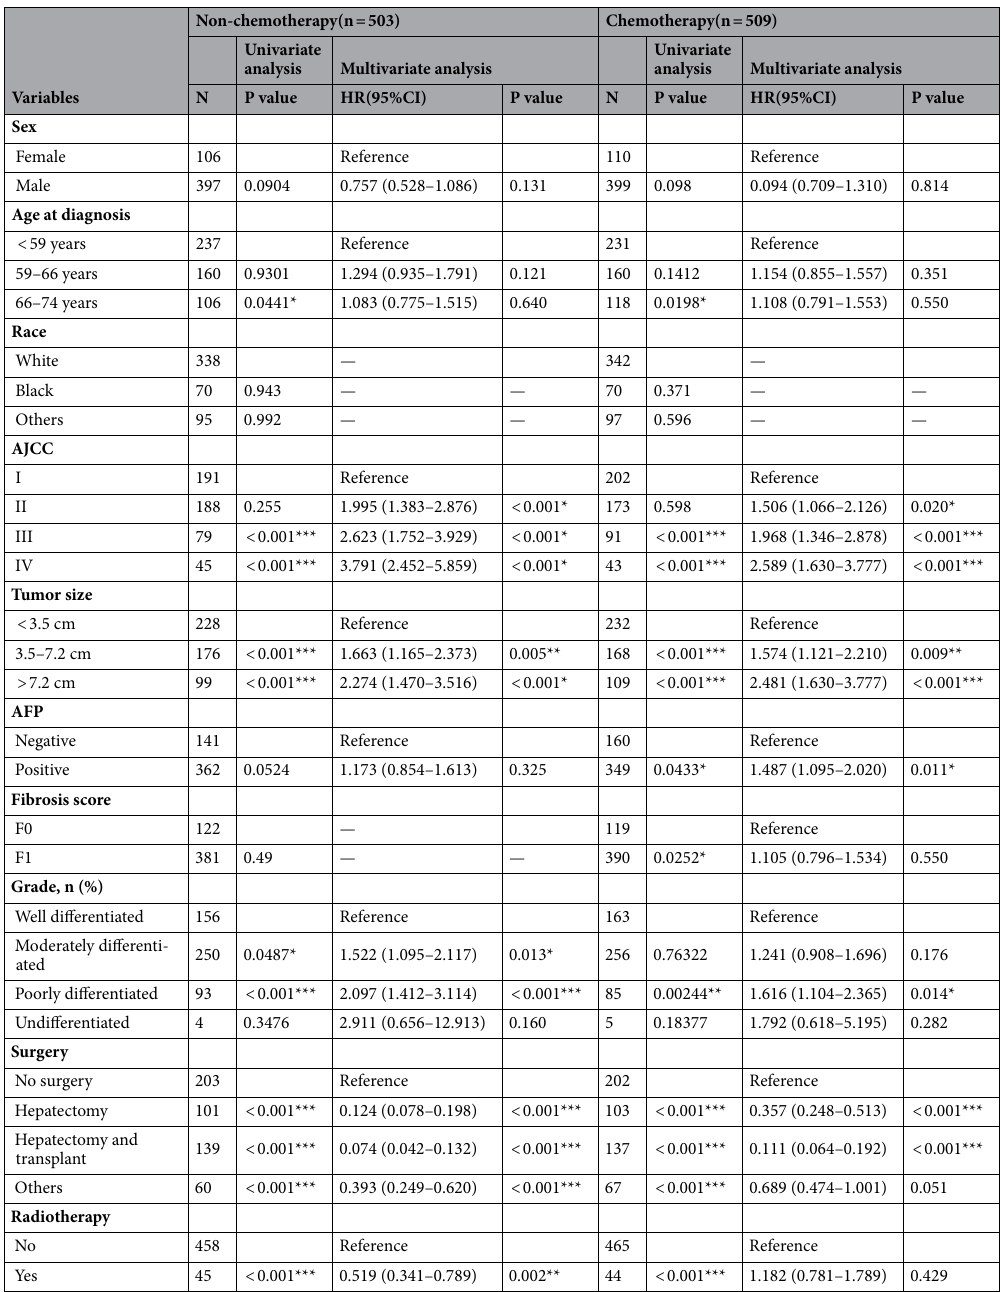
Table 3. Univariate and multivariate analysis of CSS in the patients with chemotherapy and without chemotherapy. *Two-sided P values < 0.05. **Two-sided P values < 0.01. ***Two-sided P values < 0.001. CSS, cancer-specific survival; HR, hazard ratio; CI, coindidence intervals; AJCC, American Joint Committee on Cancer (7th). F0, fibrosis score 0–4, non to moderate fibrosis; F1, fibrosis score 5–6, severe fibrosis and